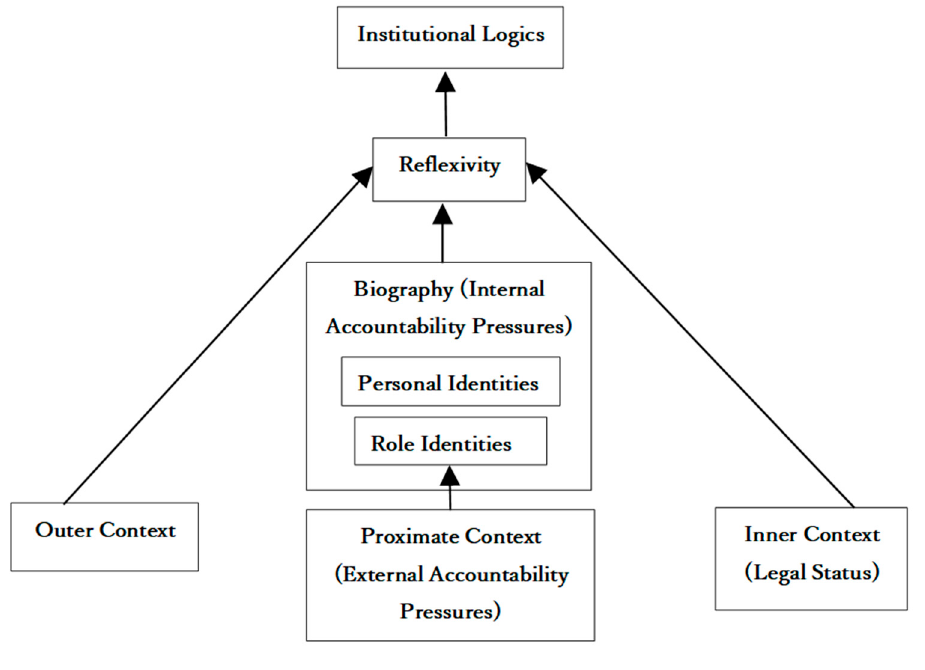
Figure 2. Social entrepreneurs’ process of choosing institutional logics. Source: Author.